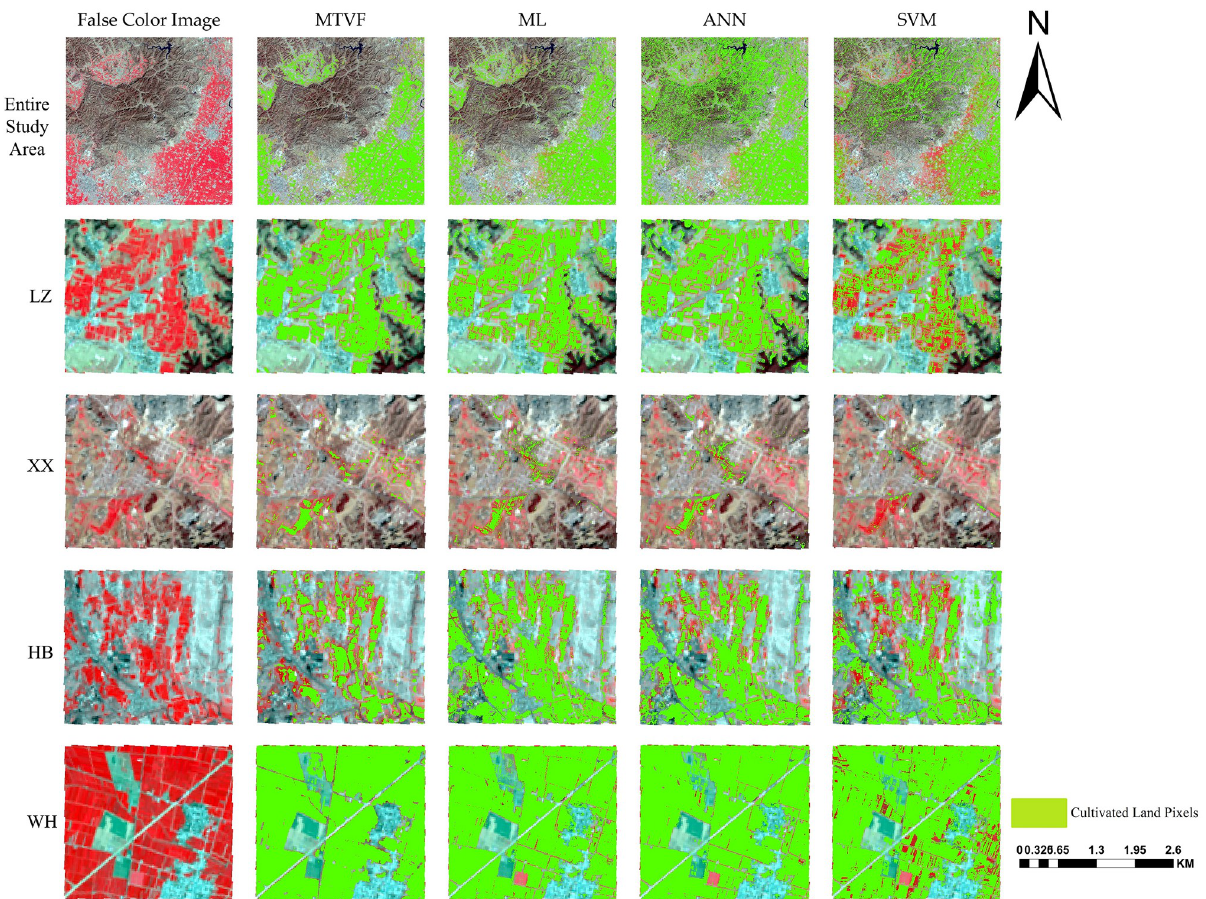
Fig 6. Comparison of cultivated land mapping for 2020. Note: the remote sensing image shown in this figure is a pseudo-color (R: NIR, G: Red, B: Green) Landsat 8 image acquired on March 19, 2020, and the cultivated land pixels are displayed in green. The image in Fig 6 is similar but not identical to the original figure used in the study, and therefore, it is presented for illustrative purposes